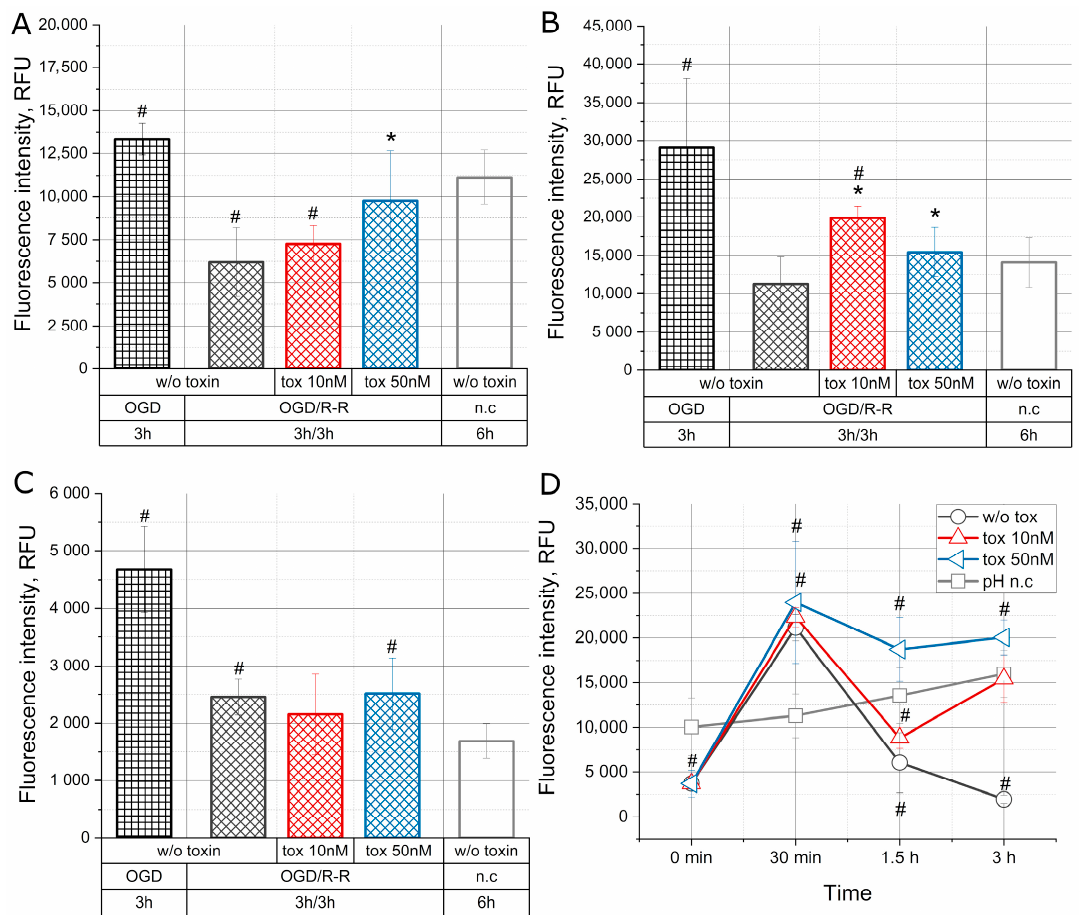
Figure 3. Change in the concentration of sodium ( A ), calcium ( B ), and potassium ( C ) ions and pH ( D ) in the CHO-K1 culture with the toxin effect at concentrations of 10 nM and 50 nM under conditions of OGD/R-R (OGD—oxygen–glucose deprivation, R-R—reoxygenation-reperfusion; n.c.—normal condition); RFU—relative fluorescence units); *— p < 0.01 when compared with the “OGD w/o toxin” group, #— p < 0.01 when compared with the “n.c.” group.